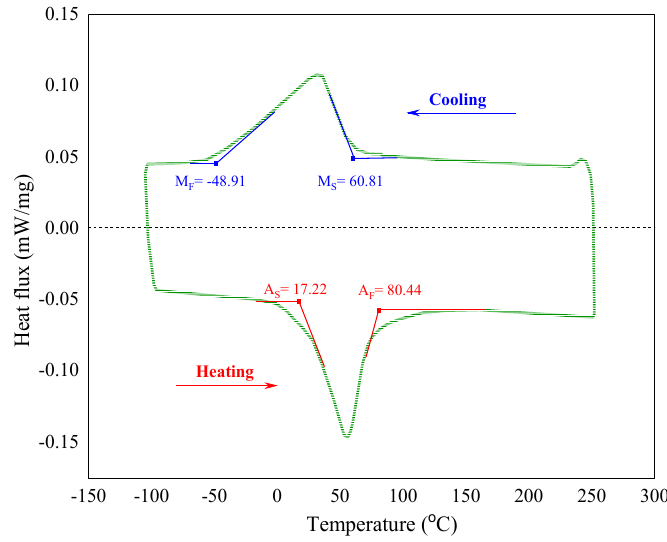
Figure 8. DSC curves of the martensite SMA beam. According to the ASTM E8/E8M-16AE1 and E9-19 (2016), several standard samples are fabricated, and then using the Universal Test Machine (UTM), tensile and compressive tests are carried out to determine the stress–strain behavior (Figure 9a,b). Furthermore, three prismatic beams with circular (diameter 20 mm and length 300 mm) and two rectangular cross-sections (height 10 mm, thickness 14 mm and length 100 mm) are subjected to three- and four-points bending tests to measure the force–deflection relationship at different conditions (Figure 9c,d). All experiments have been performed under displacement control and at the speed of 1 mm/min. Note that, the manufacturer, model, and country of test device, respectively, for DSC are NETZSCH, LFA 467, Selb, Germany, and for tensile, compressive, and bending tests is MTS, 500 kN-370.50, Eden Prairie, MN, USA.